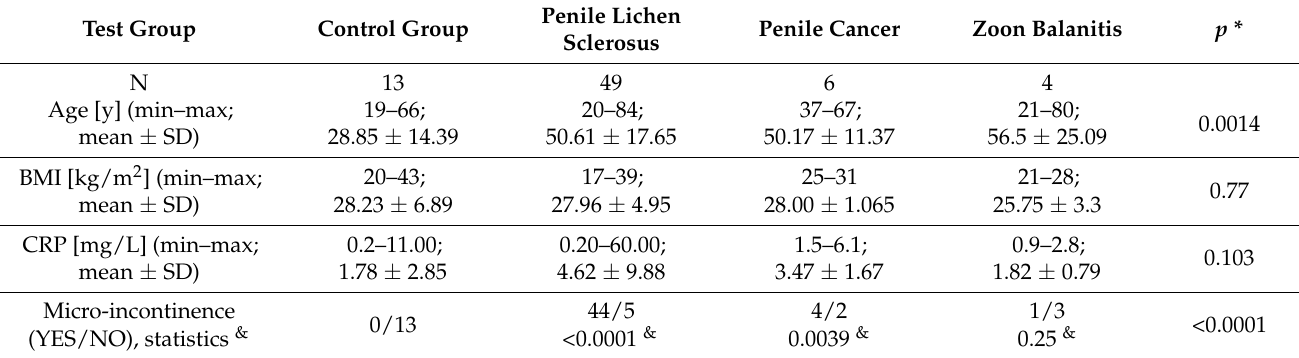
Table 1. Clinical data of patients enrolled in the